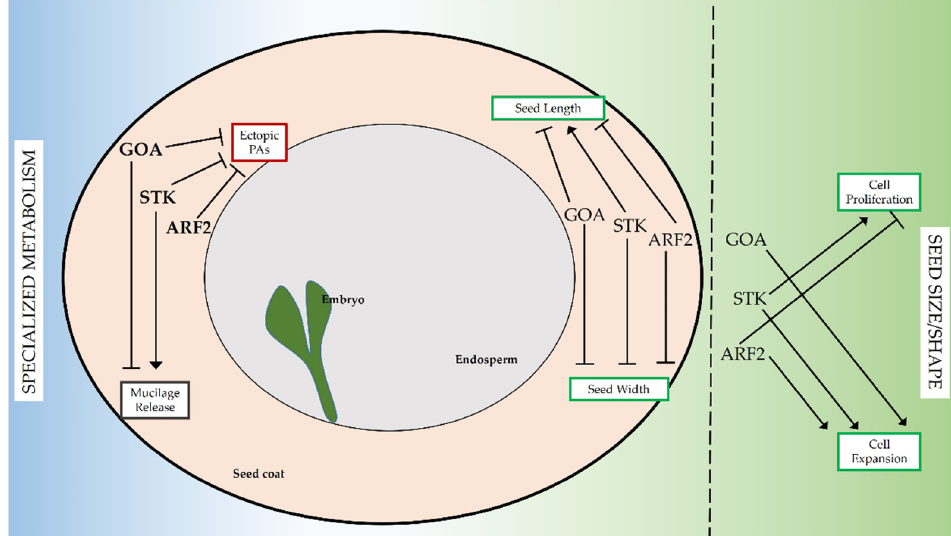
Figure 6. Network involving STK, GOA and ARF2. Throughout seed development STK, GOA and ARF2 create dynamic networks to control the production of specialized metabolites (PAs and mu- cilage, left) or define seed size and shape (right). An arrow indicates an activation, a bar at the end of an edge indicates an inhibition. end of an edge indicates an